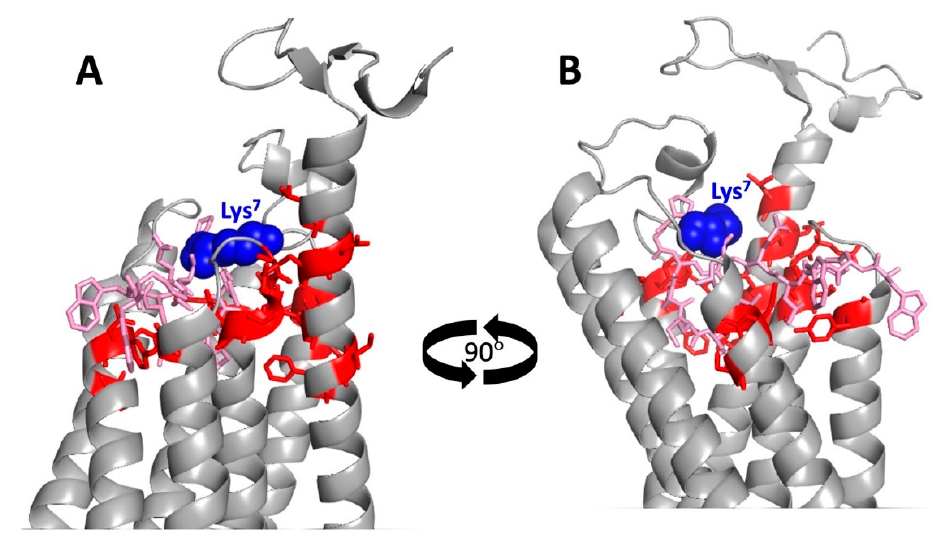
Figure 7. Locations in the Ste2p three-dimensional structure of residues that, when mutated, result in altered fluorescence emission of bound [Lys 7 (NBD),Nle 12 ] α -factor [64]. Panels ( A , B ) show views rotated 180 degrees with respect to each other. Bound α -factor is shown as a pink stick representation with residue Lys 7 shown as blue spheres. The sites of mutations that alter the fluorescence of the bound α -factor derivative are shown in red as stick representations. Note that the position of the NBD group conjugated to Lys-7 of α -factor is likely to be shifted compared to the indicated position of the native Lys 7 side chain, since the bulkier derivative is sterically excluded from occupying the same location [77].